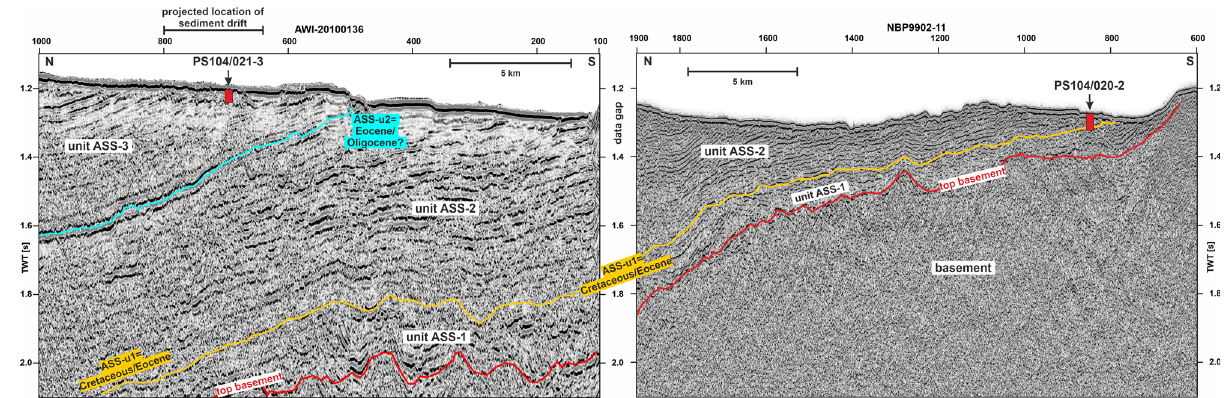
Fig. 5 Seismic transect connecting drill Sites PS104_20-2 and PS104_21-3. Note that different acquisition parameters characterise seismic pro fi les NBP9902-11 (single-channel 65 ) and AWI-20100136 (multi-channel 35 ) resulting in different frequency content and resolution. The red boxes show the locations and penetration of the two seabed drill sites 36,38,72 . Seismic sections are shown in two-way travel time (TWT). For location of seismic lines see enlarged map in Fig. 1.